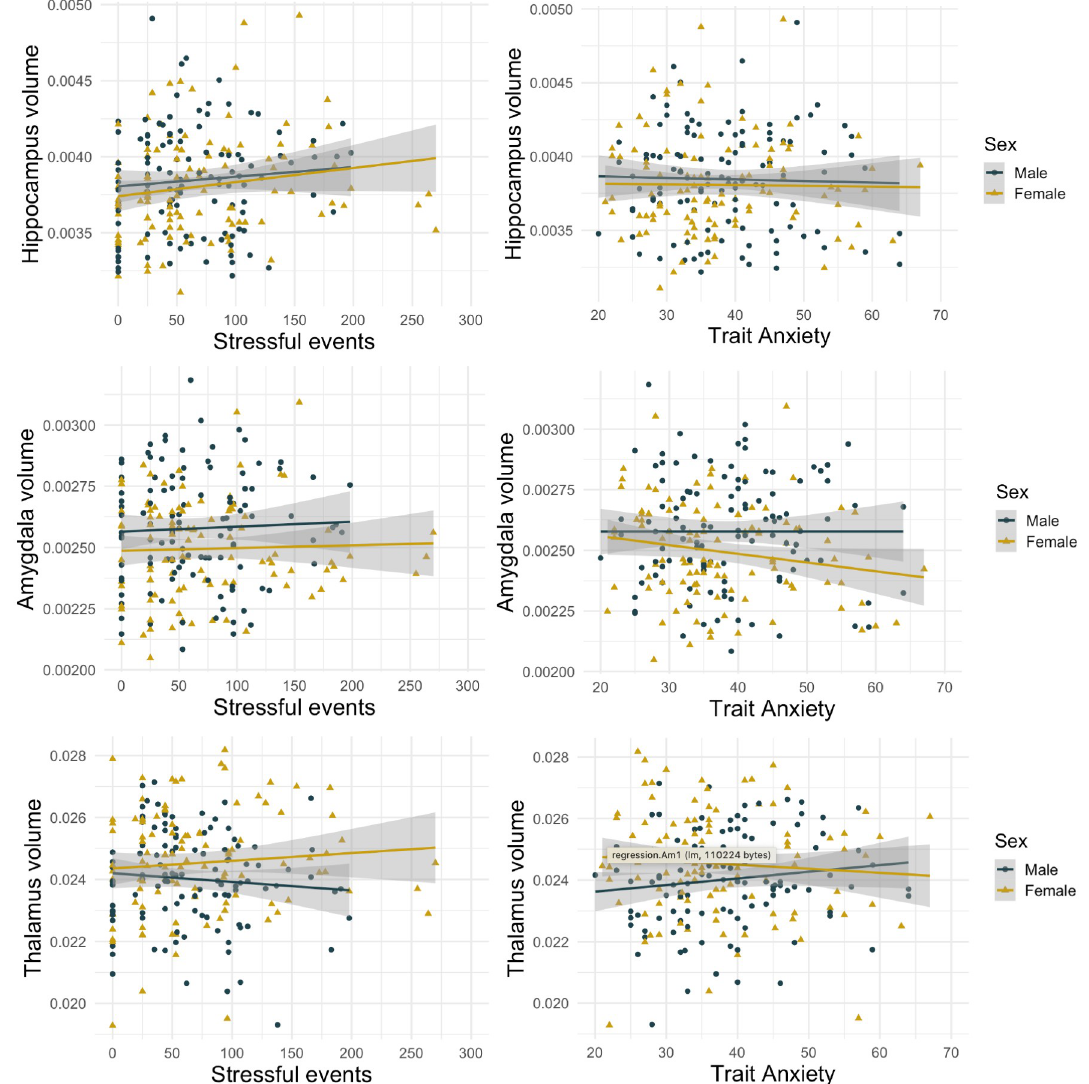
Fig 2. Scatterplots for correlations between maternal trait anxiety/stress and volumes for the hippocampus, amygdala, and thalamus. See Fig B in S1 File for partial regression scatterplots. (B = -.000000028, t = -.114, p = .909) or trait anxiety (B = -.0000013, t = -1.000, p = .319) (Table H in S1 File). An alternative model removing these two variables performed better (R 2 = .27, AIC = -3123.95) than the original model (R 2 = .27, AIC = -3121.05). Direct Spear- man correlations showed no evidence for a relationship between amygdala volume and stress- ful life events (r = .02, p = .770) or trait anxiety (r = -.05, p = .505) (Fig 2). As the model showed deviations from linearity (Text in S1 File), we repeated the analysis removing 3 outliers (stressful life event scores > 250). The new model revealed similar results (Table H in S1 File). Thalamus volume. Thalamus volume was not accurately predicted by the model (R 2 = .08, F(8,210) = 2.40, p = .017). There was no significant relationship between thalamus volume and stressful events (B = -.00000021, t = -.10, p = .920) or trait anxiety (B = -0.00000067, t = -.05, p = .953) (Table I in S1 File). Direct Spearman correlations showed that there was no